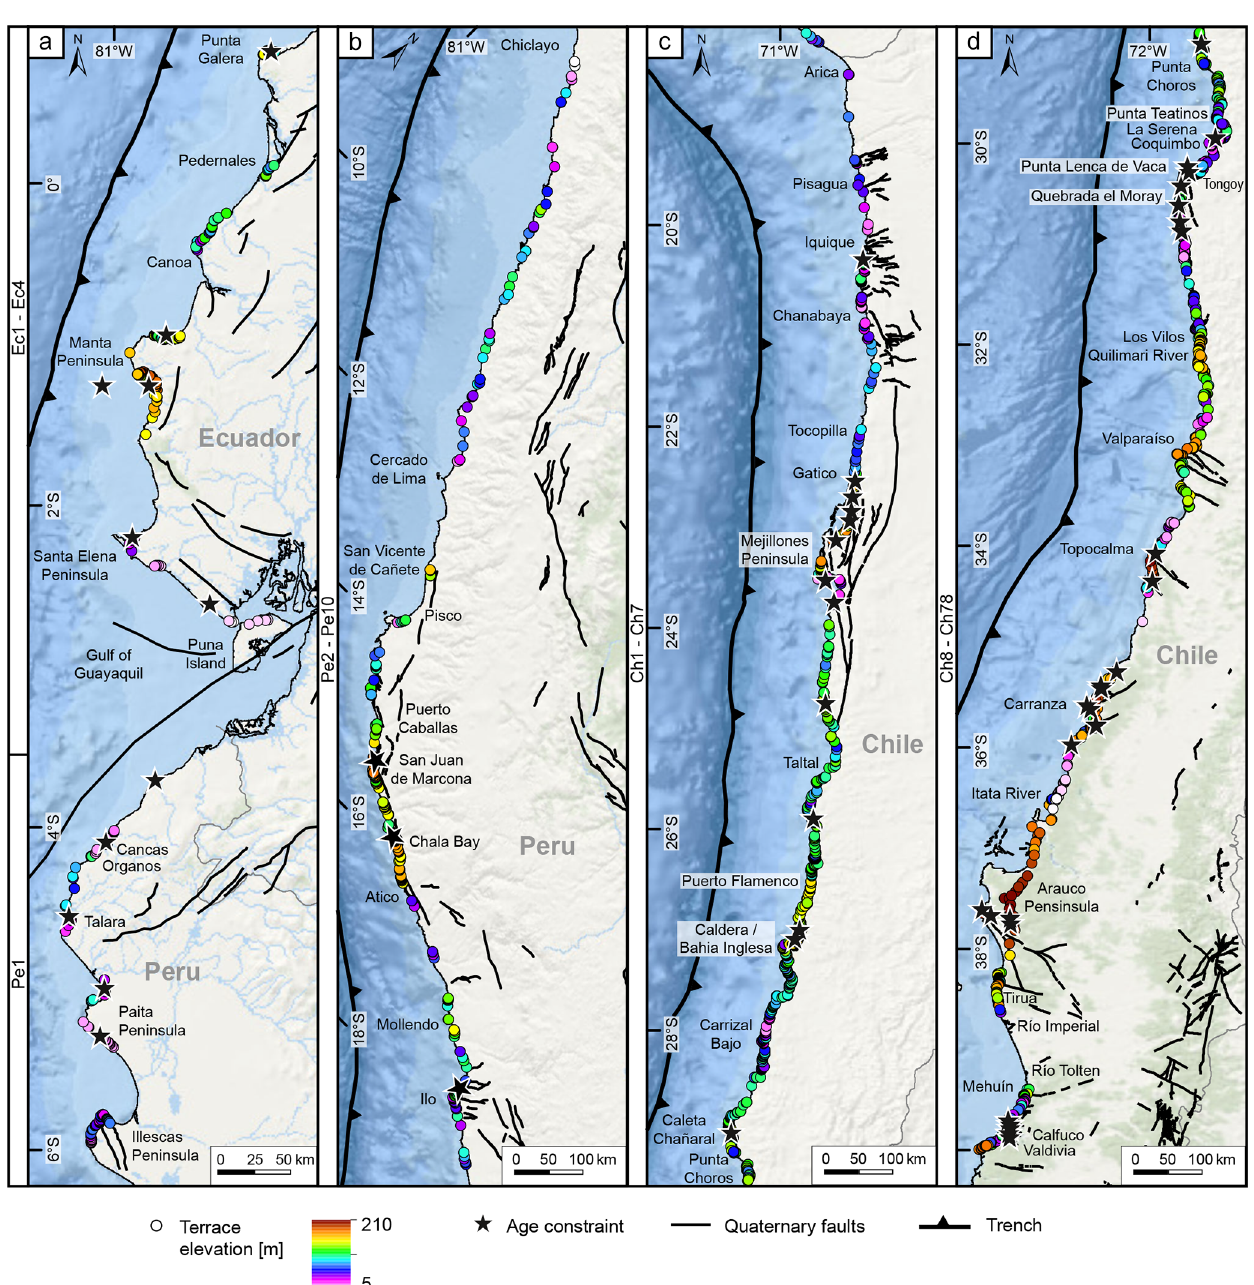
Figure 5. Shoreline-angle elevation measurements (colored points), referencing points (black stars), Quaternary faults (bold black lines) (Veloza et al., 2012; Maldonado et al., 2021), and locations mentioned in the text for the four main geomorphic segments (for location see Fig. 1a) (World Ocean Basemap: Esri, Garmin, GEBCO, NOAA NGDC, and other contributors). Site names referring to the entries in the WALIS database are on the left margin of each panel (Pe – Peru, Ec – Ecuador, Ch – Chile). (a) Talara bend in Ecuador and northern Peru. (b) Central and southern Peru. (c) Northern Chile. (d) Central and south-central Chile.